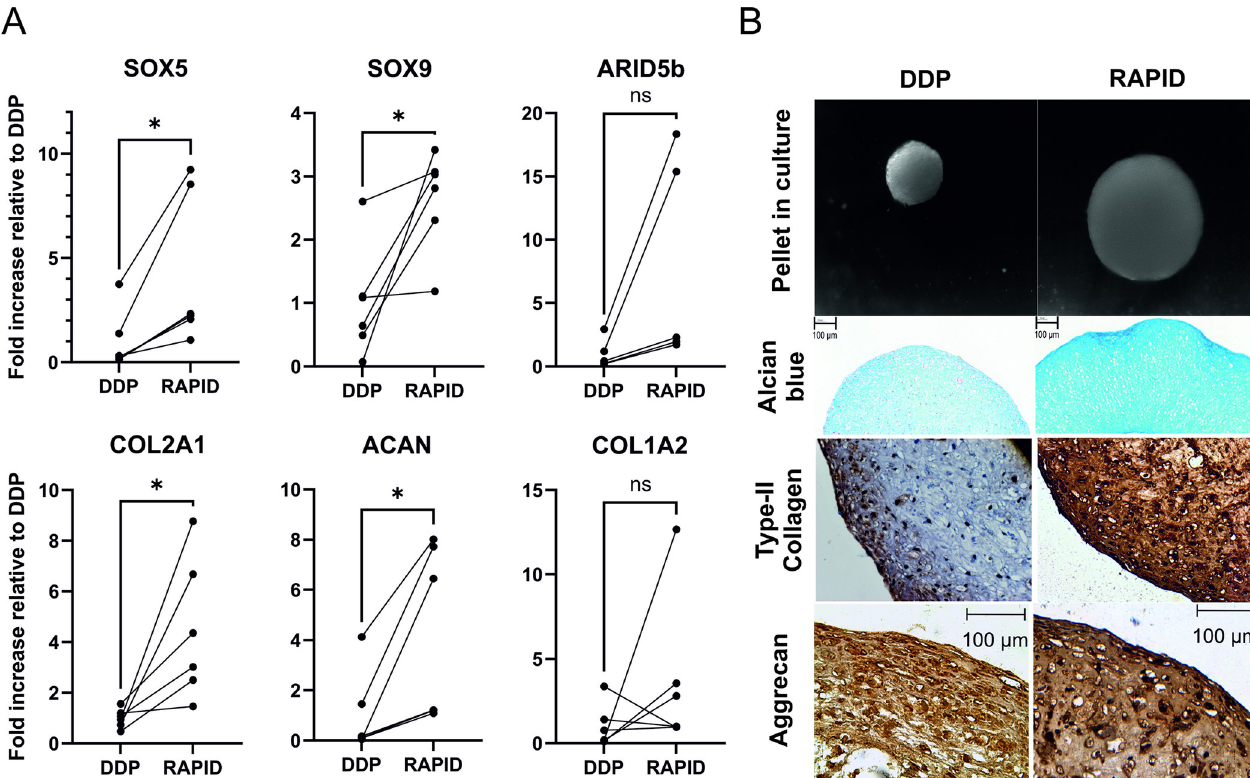
Fig 6. Comparison in chondrogenic gene expression between paired existing DDP and lateral plate derived RAPID cells. Man7 PSCs were differentiated to prechondrocytes through both the DDP and RAPID protocols. A) QRT-PCR gene expression assessment for the main transcription factors and ECM components in pair match DDP and RAPID samples. DDP samples were taken at day 14 compared to day 11 in the RAPID protocol. Data is expressed as normalised to existing DDP protocol, with connecting lines indicating paired experiments. B) Light microscopy image of pellets, Alcian blue matrix staining, immunohistochemistry for type-II collagen and aggrecan in 2D+28 day pellets. A Wilcoxen test was used to determine statistical significance. + indicates significance to hPSCs (day 0) (+ � 0.05, ++ � 0.01) (N = 6 independent experiments).